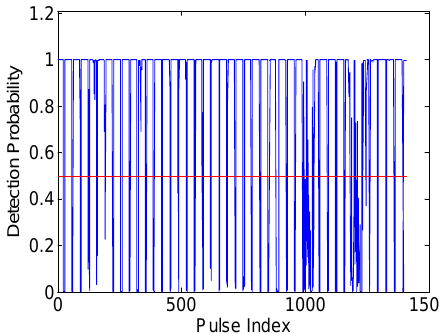
Figure 18. The representation of two measured WBI-contaminated echoes in the time–frequency domain.